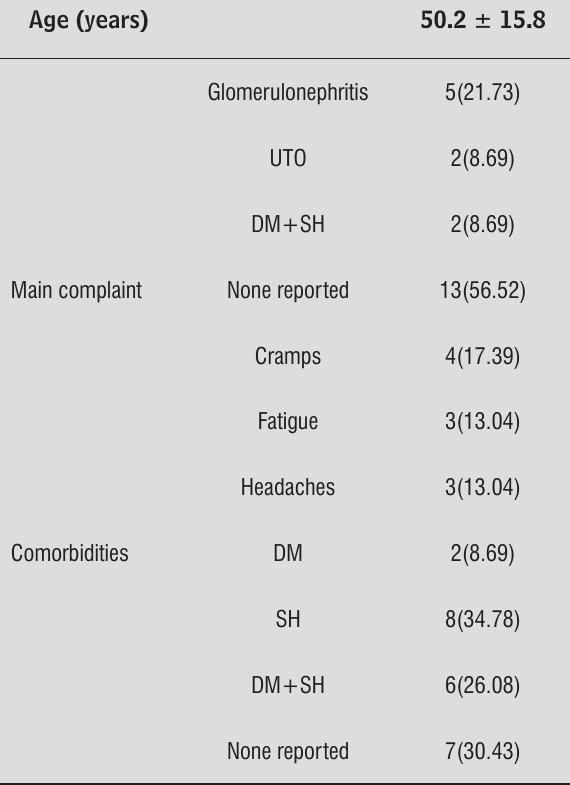
Table 1 - Sociodemographic and clinical characteristics